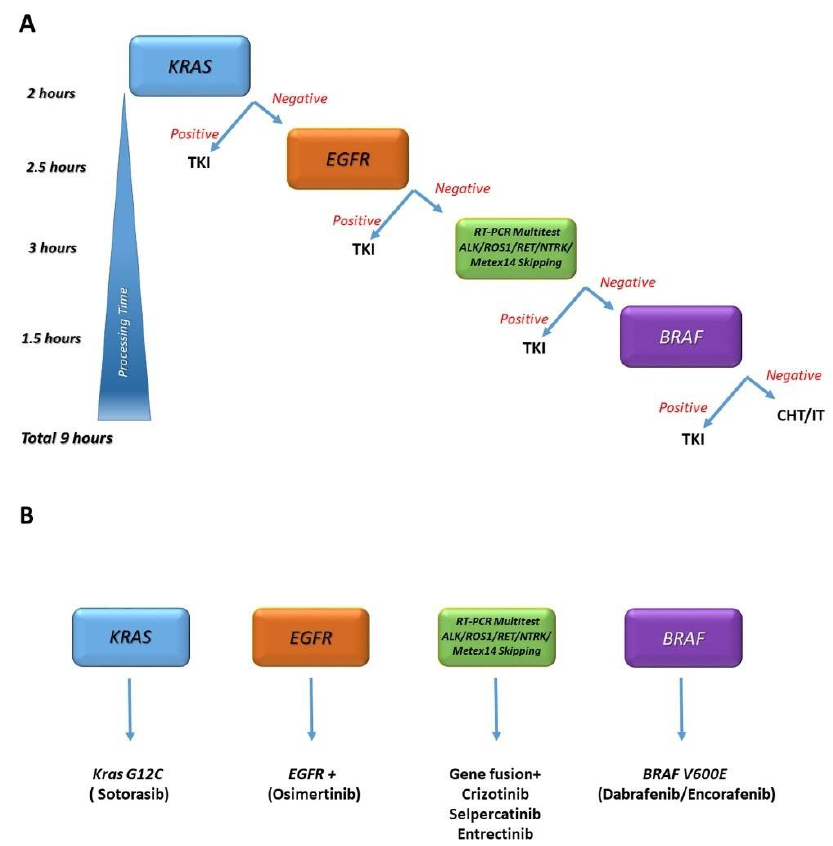
Figure 3. One day NSCLC profiling with the Idylla platform. Idylla is a fully integrated, cartridge- based assay that provides automated sample processing, including deparaffinization, tissue digestion, nucleic acid extraction, reverse transcription of mRNA, real-time PCR amplification and detection of the targeted sequences. Single KRAS , EGFR and BRAF assays are available, while the GeneFusion assay is a multitest able to simultaneously detect ALK , ROS1 , RET and NTRK translocations, along with MET ex14 skipping mutations. Using a single module, one test at a time can be performed, and testing can be stopped if a KRAS , EGFR or BRAF mutation is found, according to the algorithm (cheaper solution, panel A ). When scaling up using more modules, the profiling can be more time-efficient but also more expensive (panel B ).